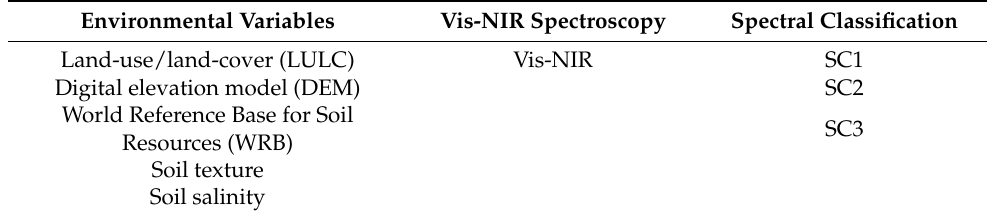
Table 1. All variables in this